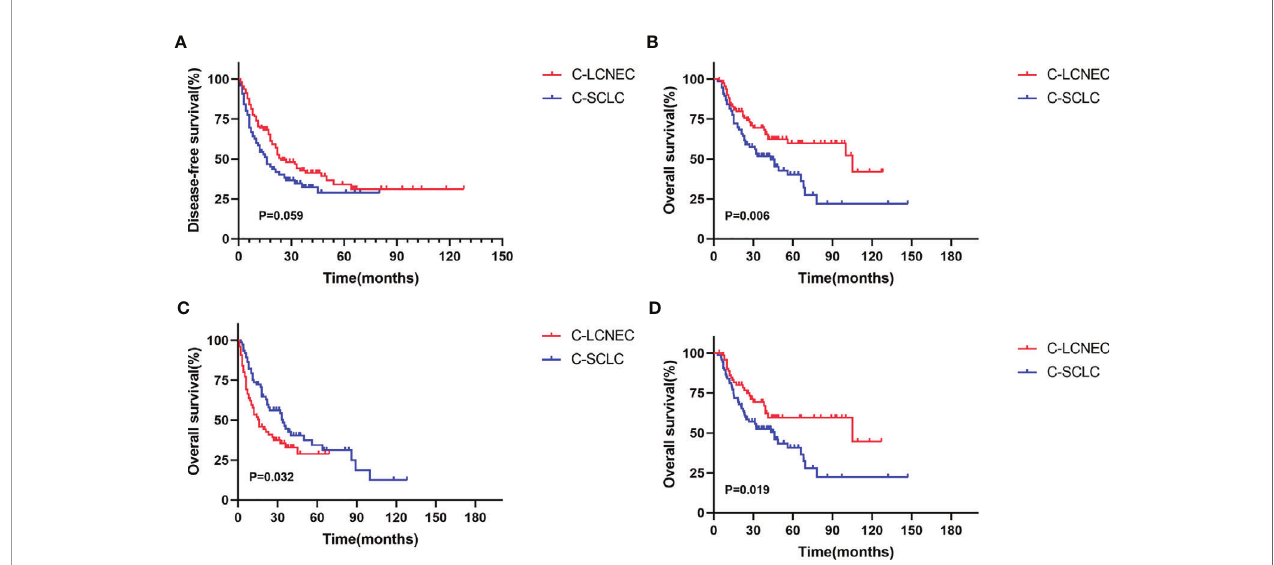
FIGURE 4 | Kaplan-Meier curves for Disease-free survival (A, C) and overall survival (B, D) before matching and after matching between C-LCNEC and